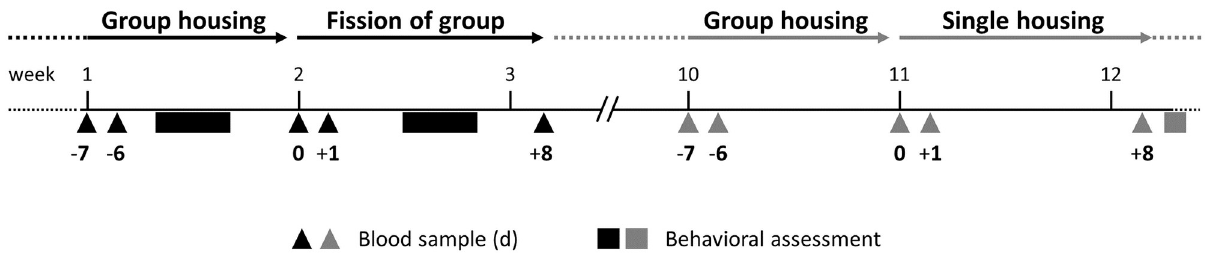
Fig 1. Scheme of study design. Two and three-year-old German Warmblood castrated male horses ( N = 15) were housed in one stable social group on pasture at the start of the study. The group was subdivided and horses were kept for eight days (d) in two groups ( N = 7 and N = 8) in different paddocks comprised of pasture. After fusion, the horse were kept again as one stable social group for a period of eight weeks. Afterwards, the horses were relocated to single housing conditions in a stable ( N = 12). Blood samples for analysis of immune cell numbers and cortisol concentrations were collected from all animals while in the stable group (-7 days, -6 days, immediately before change = 0) and 1 day and 8 days after both changes in housing conditions. Behavioral assessment of social rank and social interactions was conducted during group housing, and stereotypy-related behavior was assessed after relocation to single